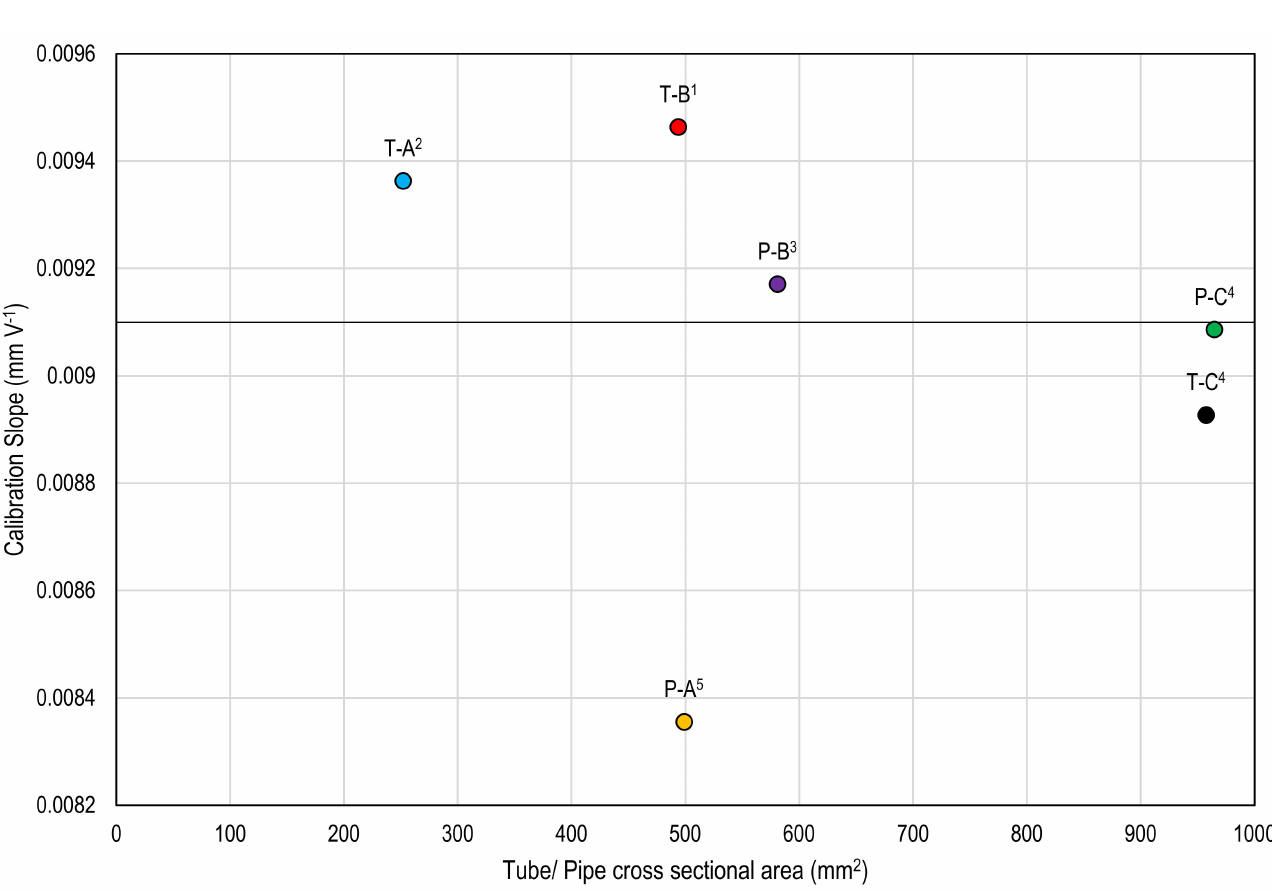
Figure 3. Cross-section area of tube/pipe ( x axis) versus the calibration slope ( y axis). Points not connected by the same letter are statistically significant, p < 0.05. The black line represents the manufacturer’s provided